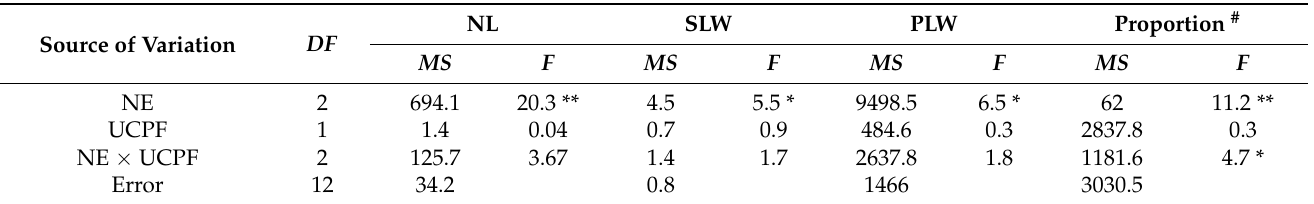
Table 5. Analysis of variance of C. bilineata tsingtauica larval growth indicators in autumn sowing net house.